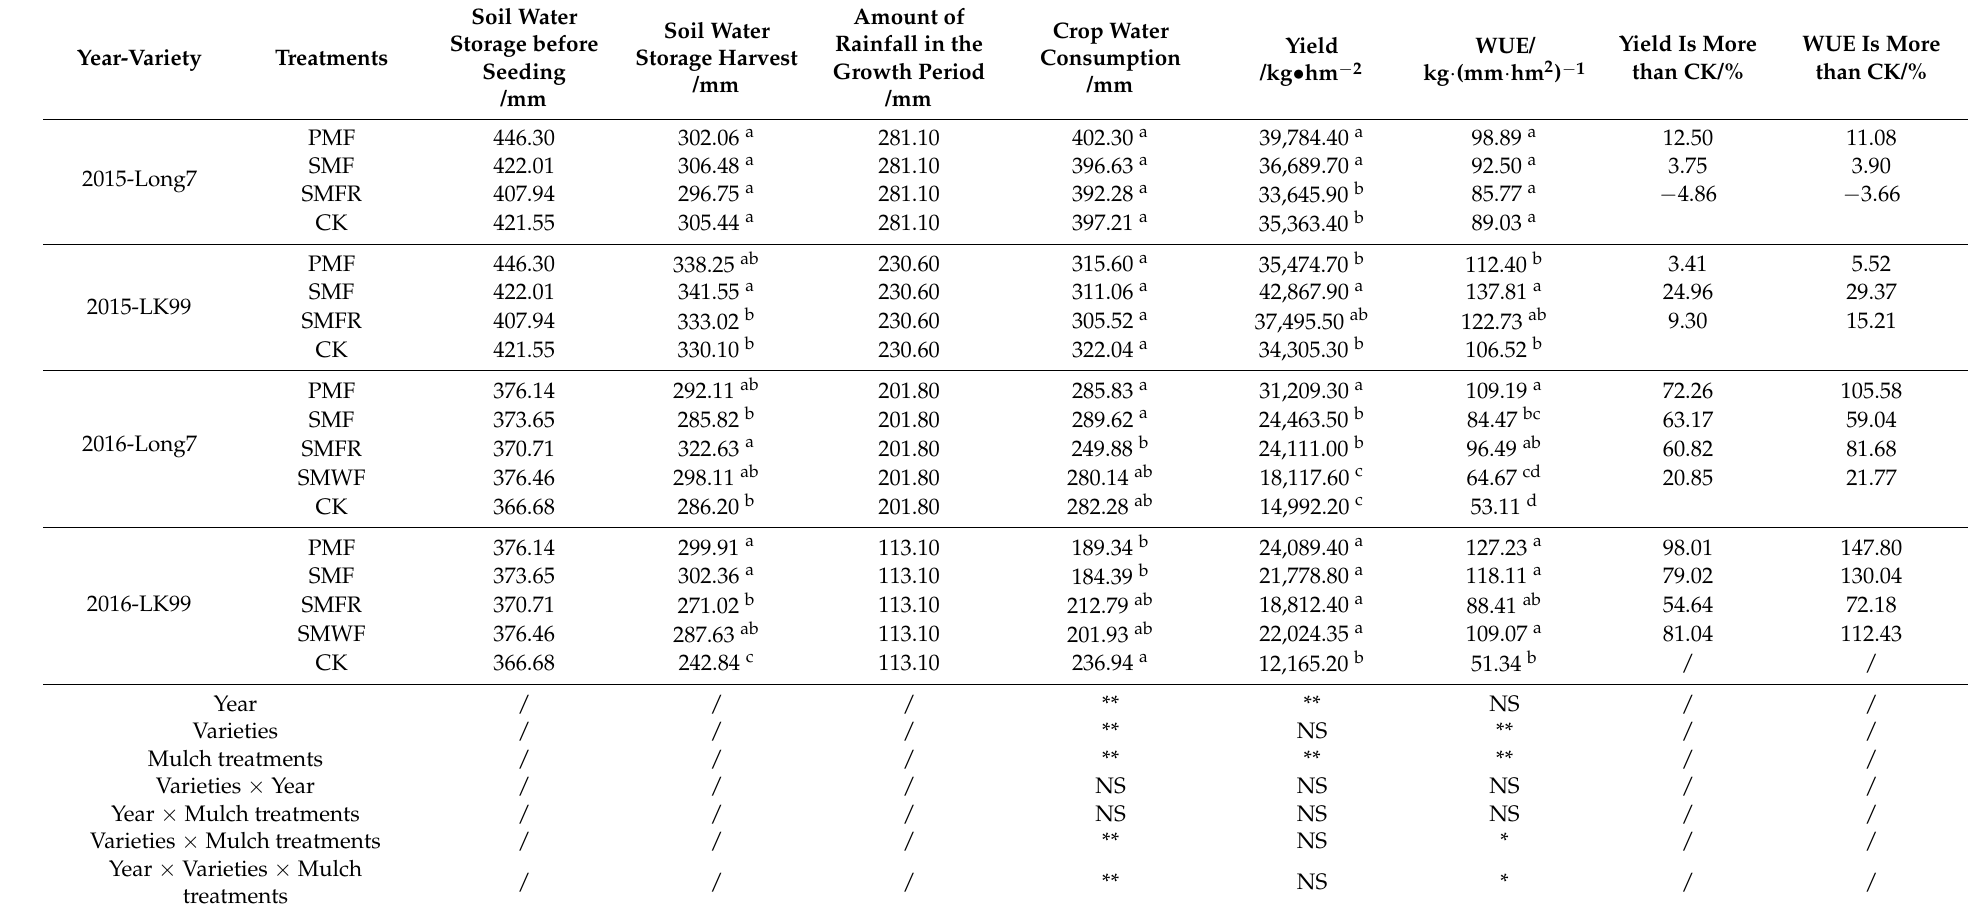
Table 3. The effects of different treatment on yield and water use efficiency (WUE) of